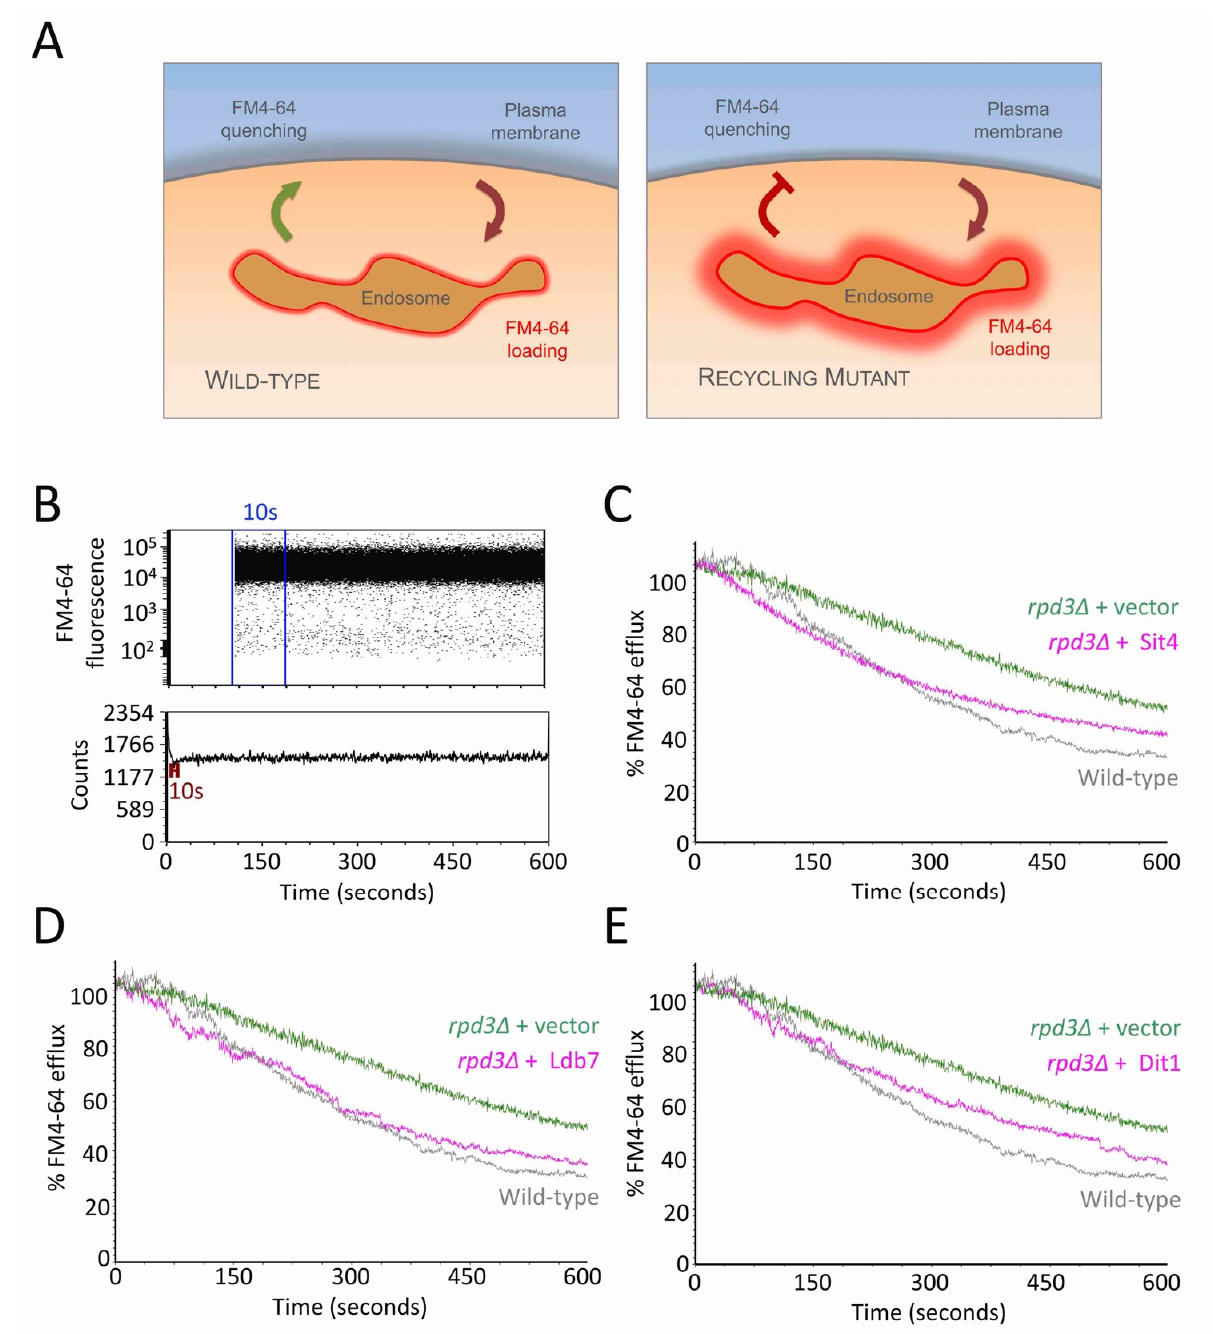
Figure 6. Over-expression of Sit4, Ldb7 and Dit1 rescues FM4-64 recycling defect of rpd3 ∆ mutants . ( A ) Schematic representation of dye recycling assay, where the fluorescent lipid dye FM4-64 is loaded to endosomes for 8 min at room temperature in YPD media containing 40 µM FM4-64, subjected to 3×3–5 min washes in ice cold minimal media prior to a small volume of washed culture (~5–15 µL) brought up in 3 mL of media maintained at room temperature followed by flow cytometry measurements. ( B ) FM4-64 fluorescence is measured by flow cytometry and the average fluorescence measured across the first 10 s is used to calculate all further measurements as a percentage of this average (upper). Voltage and flow rate are set to analyse 1000–3000 cells per second, with measurements acquired for 10 min total (lower). ( C – E ) Efflux measurements following the protocol in ( A ) were acquired for rpd3 ∆ cells transformed with plasmids over-expressing Sit1 ( C ) Ldb7 ( D ) and Dit1 ( E ). As a control, the efflux profile of wild-type and rpd3 ∆ cells labelled and measured during the same session are included in each graph.